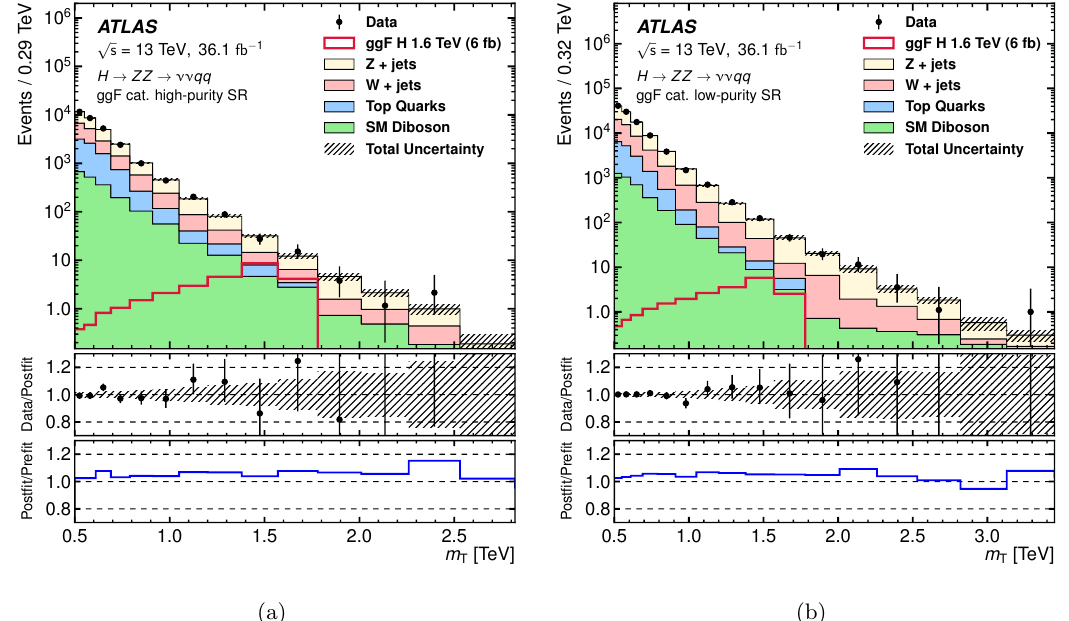
Figure 10 . Comparisons of the observed data and expected background distributions of m T in the ggF category of the H ZZ (cid:23)(cid:23)qq search: (a) high-purity and (b) low-purity signal regions. ! ! For illustration, expected distributions from the ggF production of a 1.6 TeV Higgs boson with (cid:27) ( H ZZ ) = 6 fb are also shown. The middle panes show the ratios of the observed data to (cid:2) B ! the background predictions. The uncertainty in the total background prediction, shown as bands, combines statistical and systematic contributions. The blue triangles in the middle panes indicate bins where the ratio is nonzero and outside the vertical range of the plot. The bottom panes show the ratios of the post-(cid:12)t and pre-(cid:12)t background predictions.